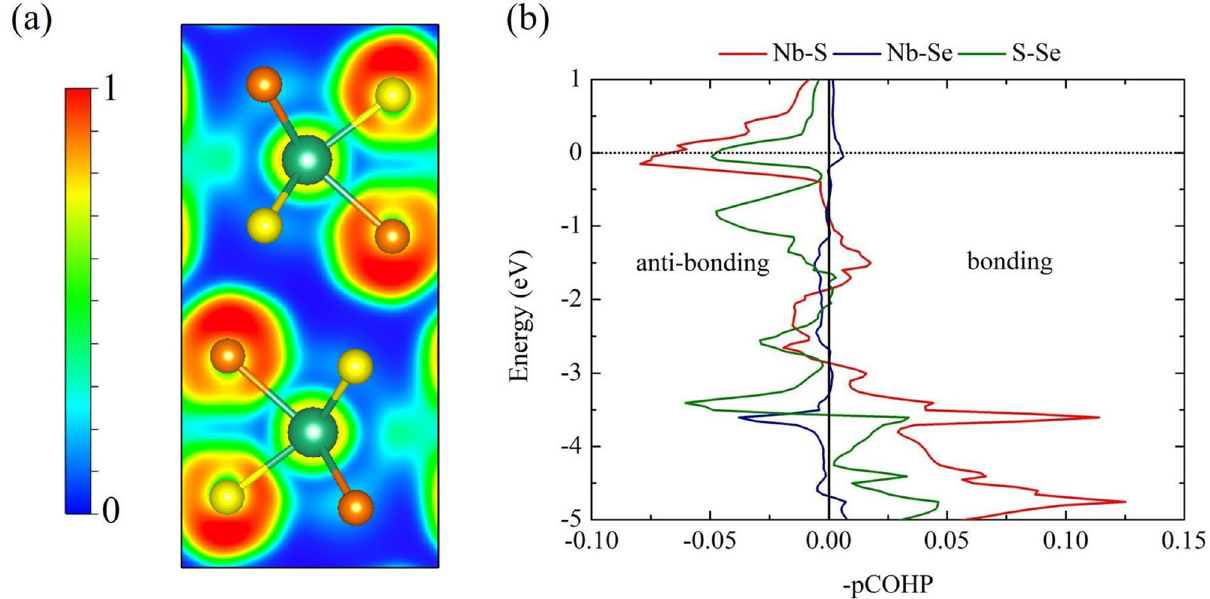
Figure 5. ( a ) The 2D–electron localization function (ELF) in the Nb(Se 0.5 S 0.5 ) 2 structure [drawn by VESTA (ver. 3.4.7) 45 (URL https:// jp- miner als. org/ vesta/ en/ downl oad. html)]. ( b ) Projected crystal orbital Hamilton populations (pCOHPs) in the Nb(Se 0.5 S 0.5 ) 2 structure, where the red line represents the Nb-S pairs, the blue line represents the Nb-Se pairs, and the green line represents the S-Se pairs,